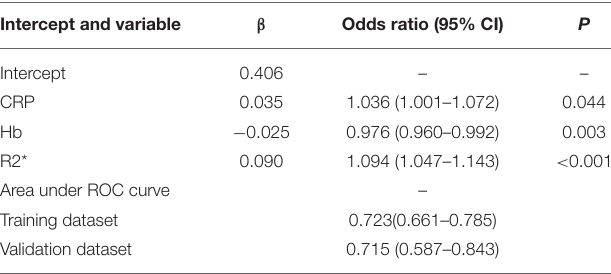
TABLE 4 | Variables in the final multi-regression model in the training dataset.